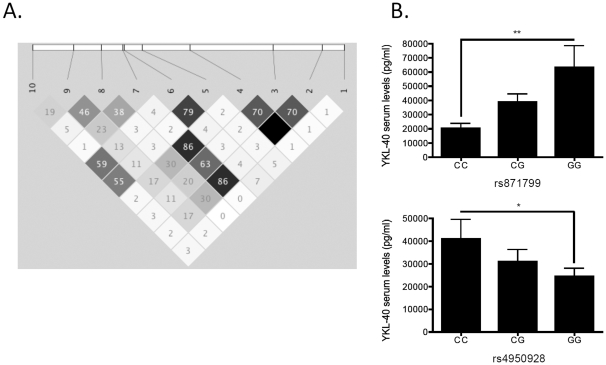
YKL-40 SNPs.A. Location and linkage disequilibrium (R2) of YKL-40 polymorphisms genotyped in the CF population. B. YKL-40 serum levels in CF patients stratified for the respective rs871799 (upper panel) or the rs4950928 (lower panel) genotype. *P<0.05, **P<0.01.